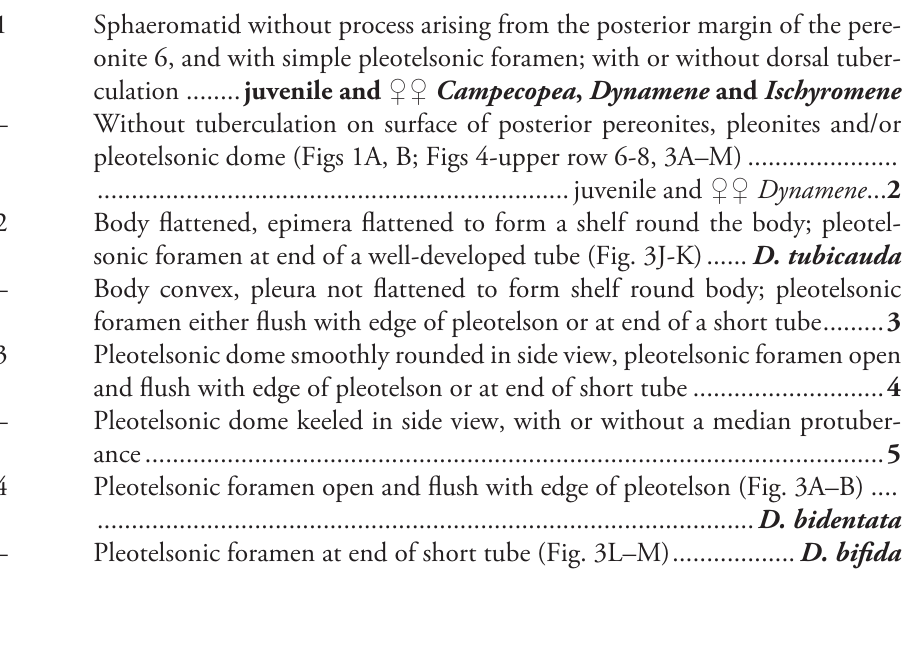
– Bidentate processes without well-developed accessory process; pleotelsonic boss well-developed, without raised pointed corners ................................... 5 5 Apices of bidentate processes swollen, each with short, downwardly-directed spur; pleotelsonic boss plate-like with two forward-facing pegs; body exhibit- ing various degree of setation, sometimes hirsute (Fig. 2E–F) ... D. edwardsi – Bidentate processes without swollen apices or spurs, pleotelsonic boss not plate-like ..................................................................................................... 6 6 Pleotelsonic boss comprised of two right-angled triangular structures sepa- rated by a deep groove (however, the boss may be very low lying in some specimens, e.g. those from the Black Sea); arms of bidentate process tapering to point, rugose dorsally (Fig. 2J–K) ............................................. D. bicolor – Pleotelsonic boss comprising two hemispherical structures separated by a wide or a narrow groove, joined at the base ................................................. 7 7 Pleotelsonic boss large, bilobed, two halves separated by a narrow groove; arms of bidentate process of similar width with along length, dorsally tuber- culate (Fig. 2C–D)............................................................... D. magnitorata – Pleotelsonic boss large, bilobed, two halves separated by a wide v-shaped groove; arms of bidentate process tapering to point, sparsely rugose dorsally (Fig. 2A–B) .............................................................................. D. bidentata